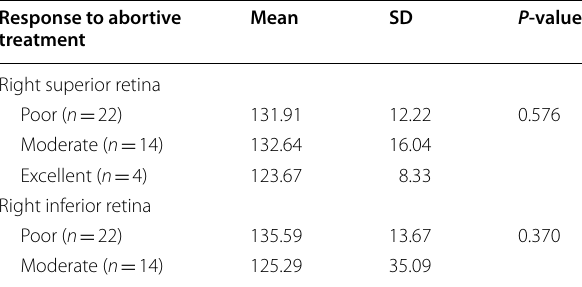
Table 5 Retinal nerve fiber layer thickness in migraine patients in relation to response to abortive treatment